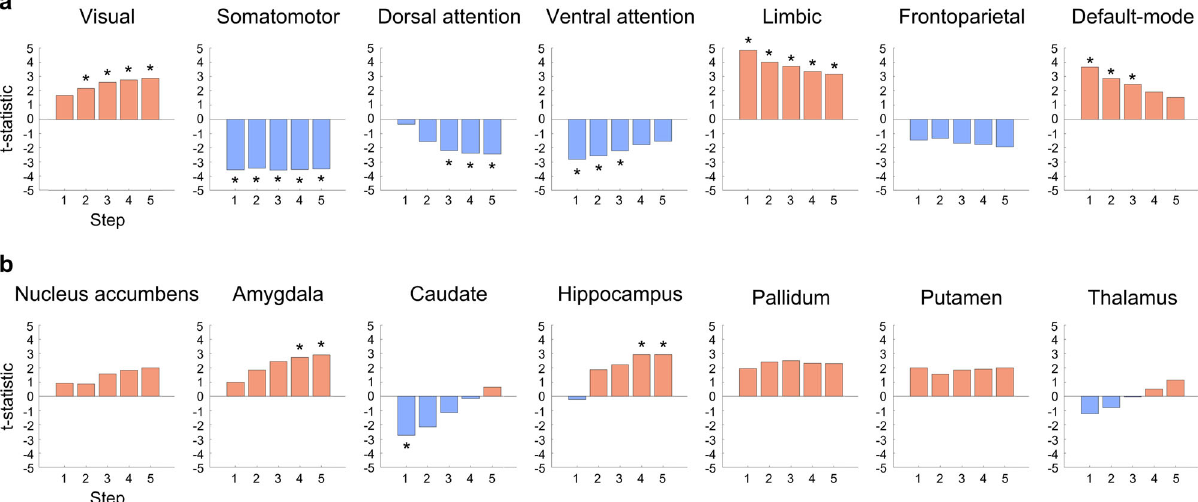
Fig. 4 Between-group differences in degree centrality values. We strati fi ed effects of between-group differences in degree centrality values according to a functional communities and b subcortical regions. Positive (red) values indicate higher degrees in OW group, whereas negative (blue) values indicate lower degrees. The t-statistics with signi fi cant between-group differences are marked with the same analyses on subnetworks of (i) cognition, (ii) reward, and (iii) sensorimotor-related regions and found virtually identical results (Supplementary Figs. 5 – 7).